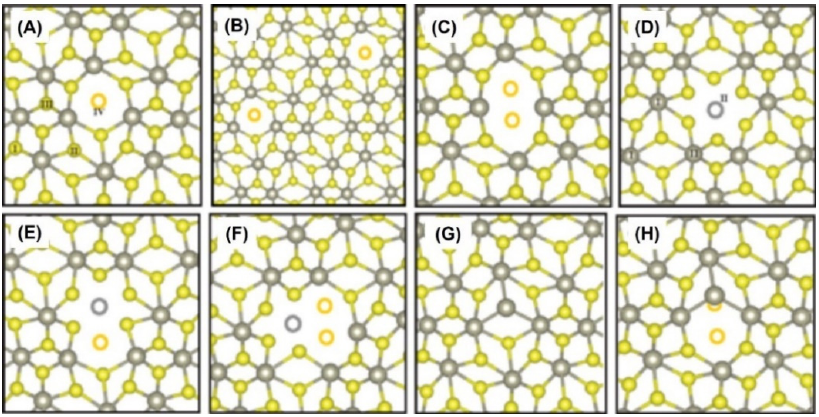
Figure 4. Atomic structure of ( A ) monosulfur vacancy V S ; ( B ) two monosulfur vacancies V S+S ; ( C ) disulfur vacancy V 2 S ; ( D ) Re vacancy V Re ; (E) ReS vacancy V ReS ; ( F ) ReS 2 vacancy V ReS 2; ( G ) single S atom substituted by a Re atom S S → Re ; and ( H ) two S atoms substituted by a Re atom S 2 S → Re . (Reprinted figure with permission from [57]. Copyright (2014) by the American Physical Society.) It is worth mentioning that S-related defects ( V S , V S+S, and V 2 S ) cannot cause mag- netism, whereas Re-related defects ( V Re , V ReS and V ReS 2 ) can. As shown in Figure 5, the mag- netization comes predominantly from p orbitals of two neighboring S atoms within the vacancy region.